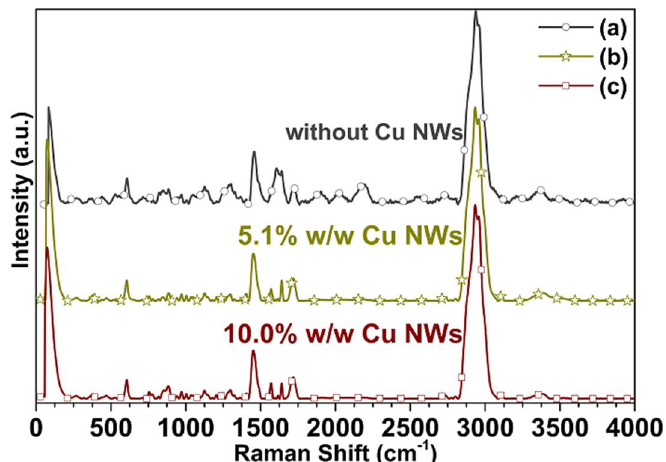
Figure 11. Raman spectra acquired on the substrates (a) without Cu NWs ( ◦ ), and with Cu NWs at (b) 5.1% w / w ( ∗ ), and ( c ) 10.0% w / w ( (cid:3)